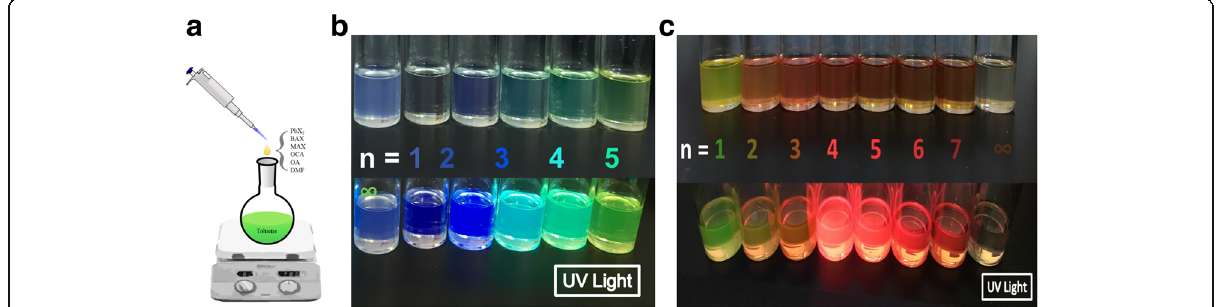
Fig. 1 a Schematic illustrating the one-pot synthesis process to prepare the 2D RP perovskite QDs at room temperature. The photographs of 2D RP perovskite QDs with b Br series and c I series dissolved in toluene taken under ambient condition (upper part) and UV light (lower part) ( λ = 365